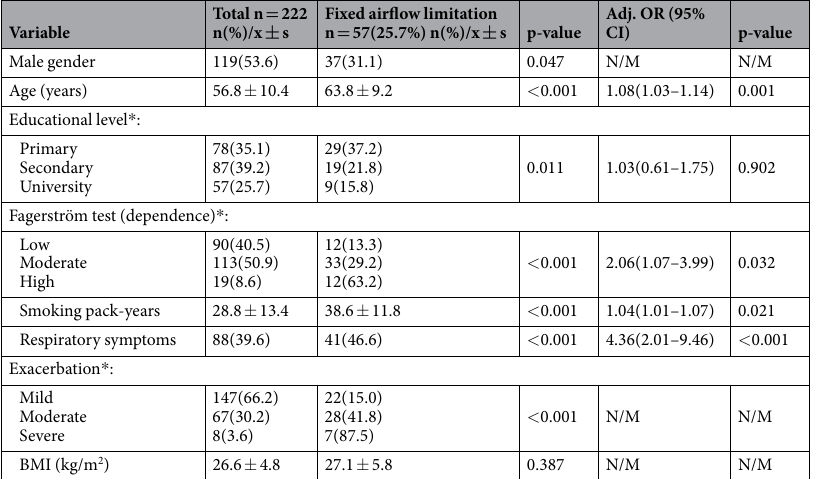
Table 2. Predictive model for fixed airflow limitation in smokers with no previous diagnosis of chronic obstructive pulmonary disease in primary health care. Abbreviations: Adj. O.R., adjusted odds ratio; B.M.I., body mass index; C.I., confidence interval; n(%), absolute frequency (relative frequency) N/M, not in the model; x ± s, mean ± standard deviation. * Analysed in the multivariate model as a quantitative variable. Goodness-of-